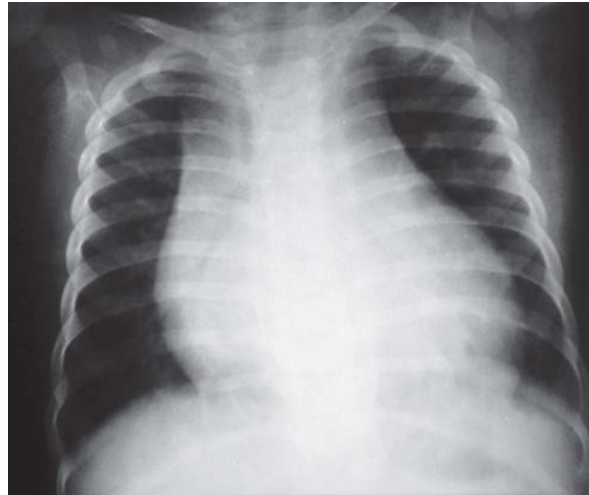
Fig. 2 – Radiograma de tórax pré-operatório